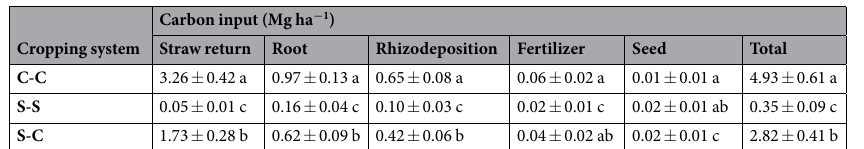
Table 2. Annual average carbon input in three cropping systems during 2005 to 2014. Data are means ± SD. Within a column, cropping systems means followed by the same letter are not significantly ( P < 0.05).